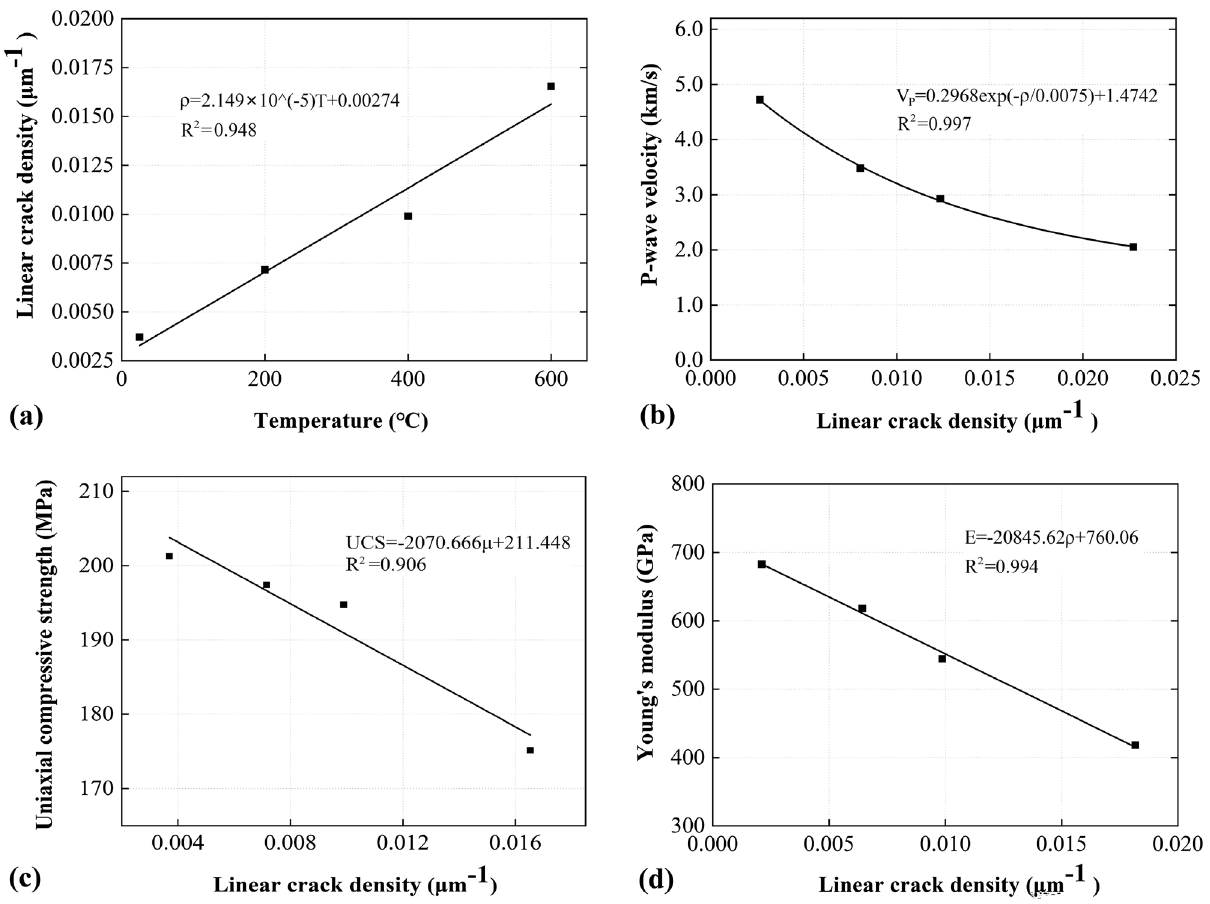
Figure 9. Correlations between ( a ) ρ and treating temperature; ( b ) V p and ρ, ( c ) UCS and ρ; and ( d ) E and